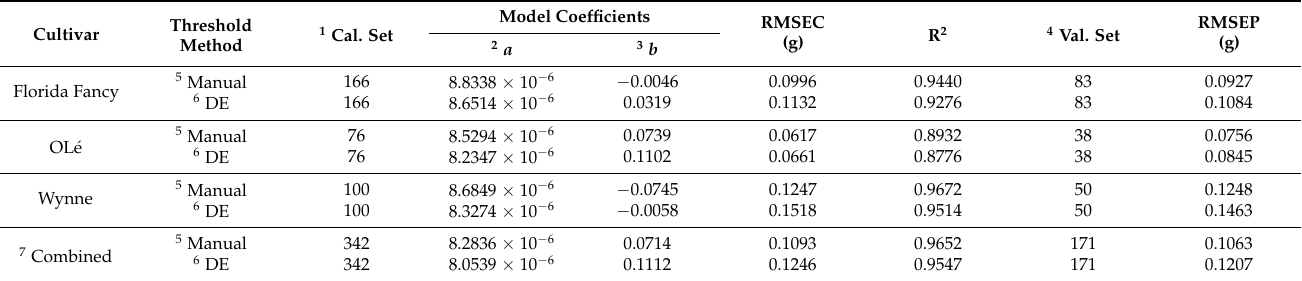
Table 3. The results of seed weight estimation models for the three peanut